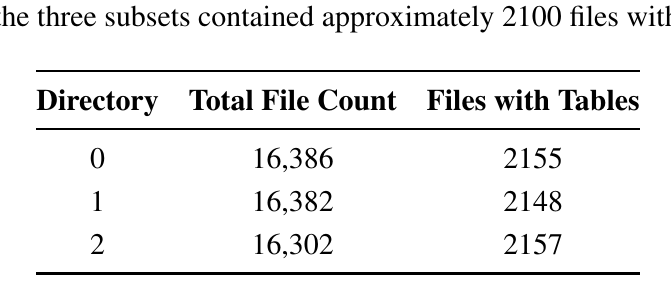
Table 3. Three directories of patent files on which the three models from Table 2 were applied. Each of the three subsets contained approximately 2100 files with